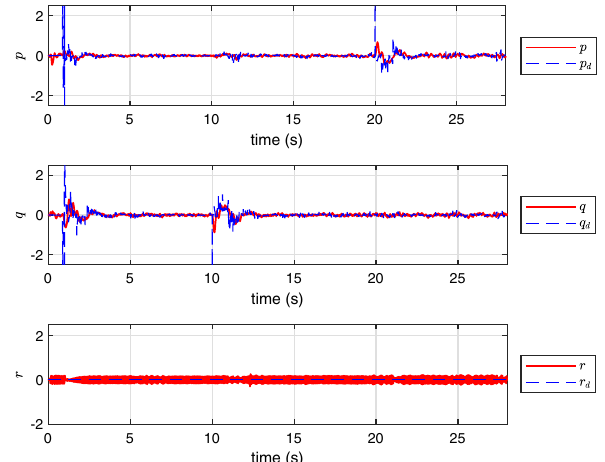
Figure 12. The profile of p , q and r in the experimental test using NAS.